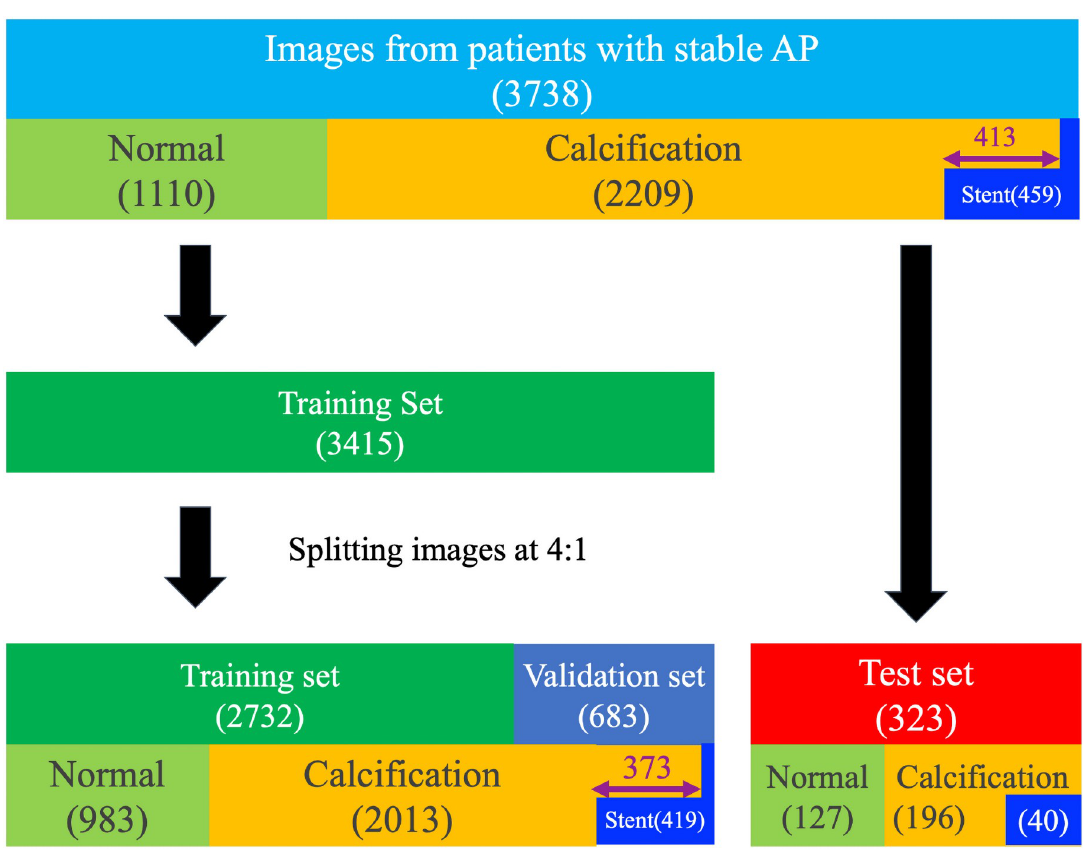
Fig 3. Study flowchart. “Normal” means that the images were without calcification or a stent. Of the 3738 IVUS images, 413 had both calcification and stents (purple double-headed arrow). In the test set, all 40 images with stents also had calcification. In the training set, 373 images with stents had calcification. AP = angina